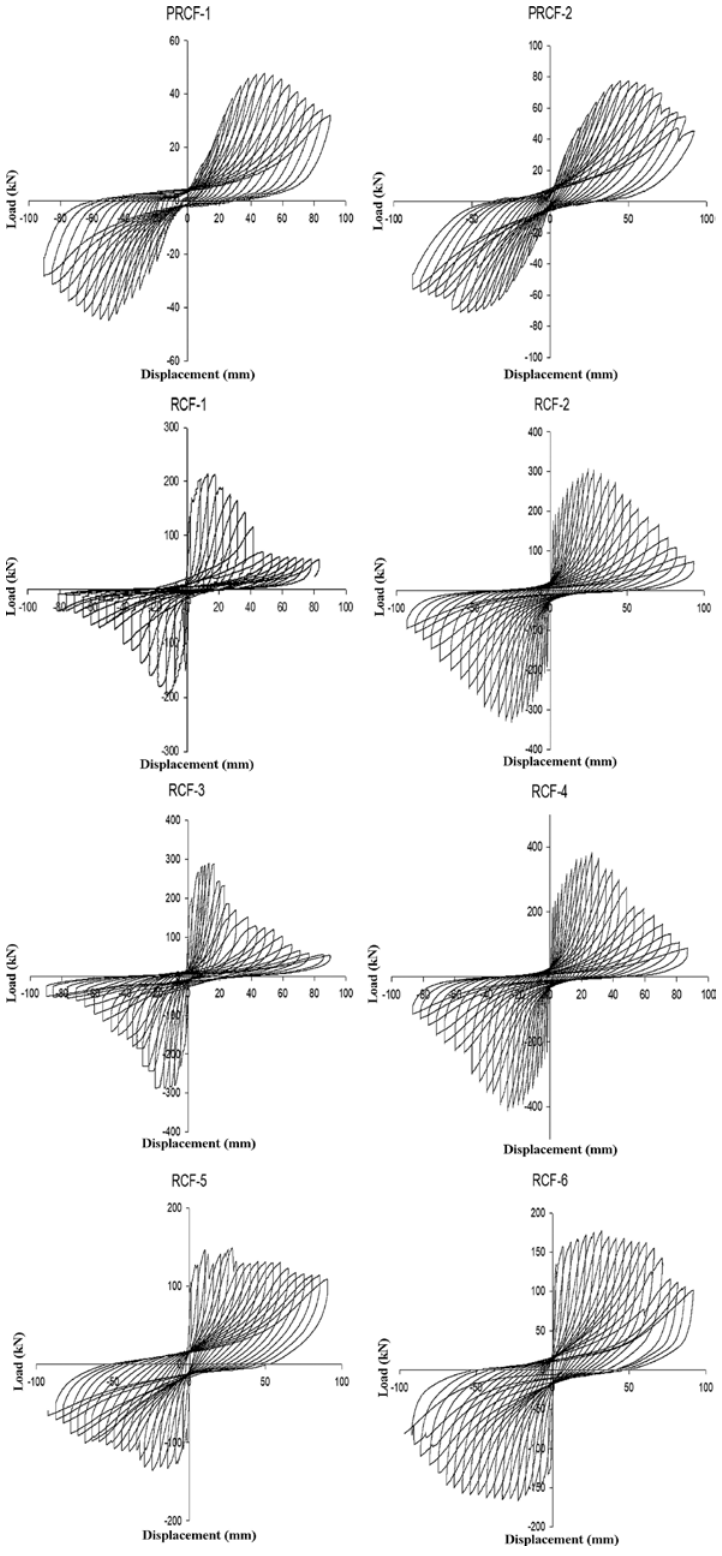
Figure 7: Hysteretic load-displacement curve of test